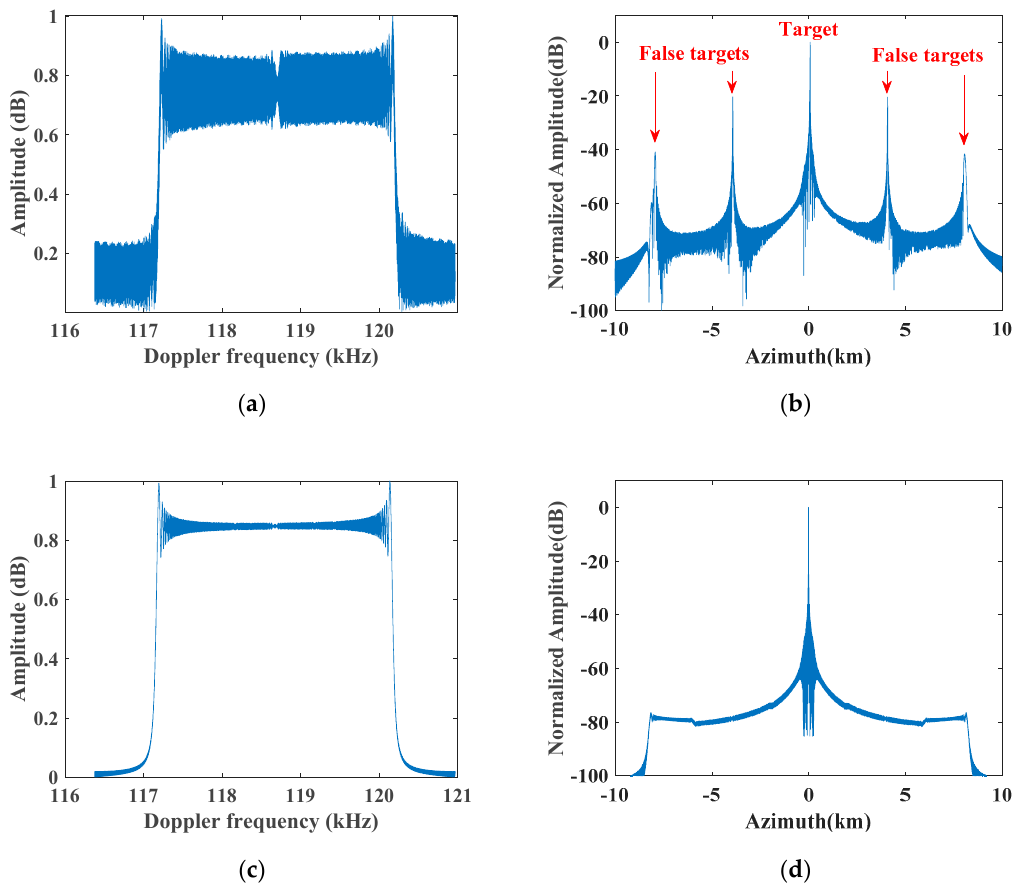
Figure 5. Azimuth multichannel reconstruction results in the monostatic DPCMAB SAR system. ( a ) Azimuth spectrum without azimuth multichannel reconstruction; ( b ) azimuth compression result without azimuth multichannel reconstruction; ( c ) azimuth spectrum after conventional azimuth multichannel reconstruction; ( d ) azimuth compression result after conventional azimuth multichannel reconstruction.